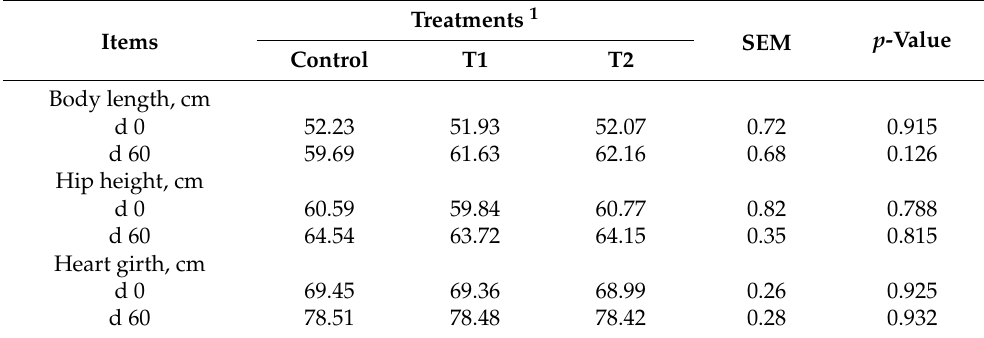
Table 3. Effect of Bacillus licheniformis and the combination of probiotics and enzymes on body size of yak calves.